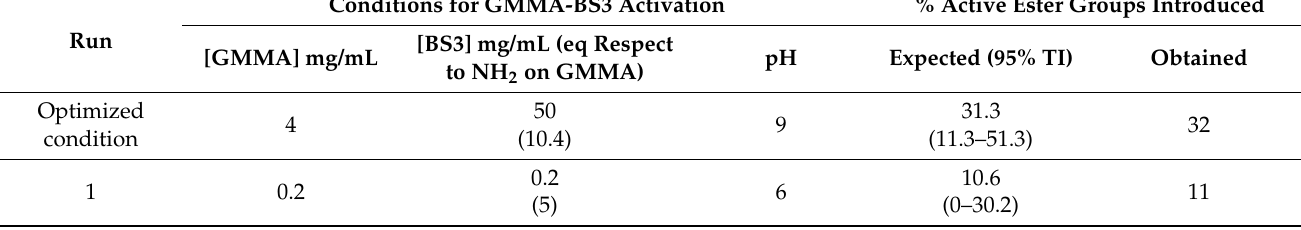
Table 2. Optimized conditions for GMMA activation with BS3 with expected responses from the model, confirmed by performing an additional test, and activation conditions selected for assessing impact of % of active ester groups on conjugation